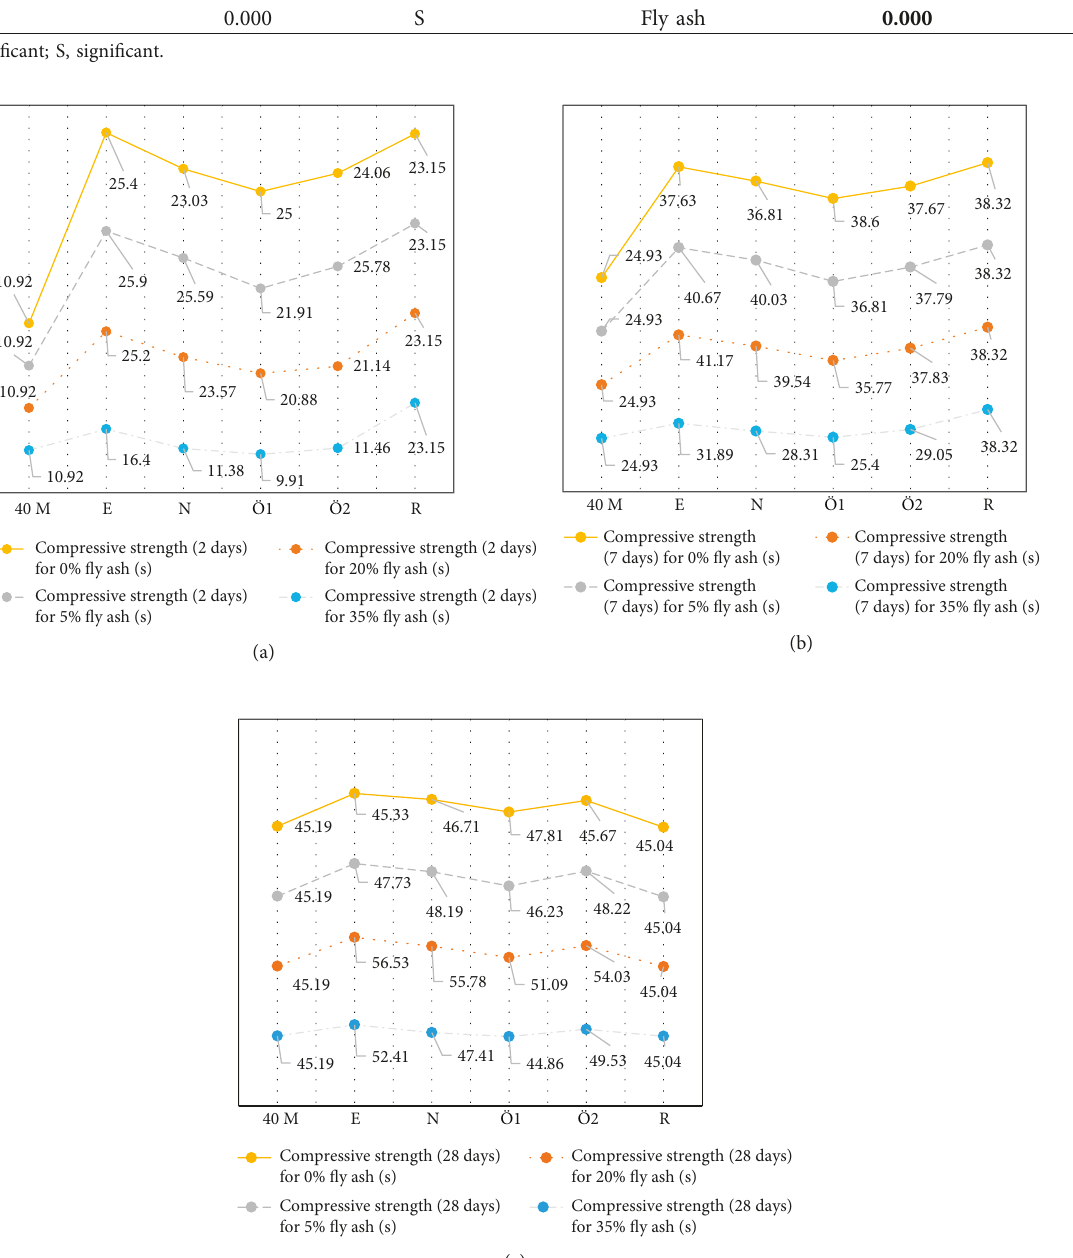
Table 4: Results of ANOVA test for water demand and setting time (significance level α Water demand P value Significance Setting time P value Significance Cement chemical 0.958 NS Cement chemical 0.912 Dosage of chem. additive